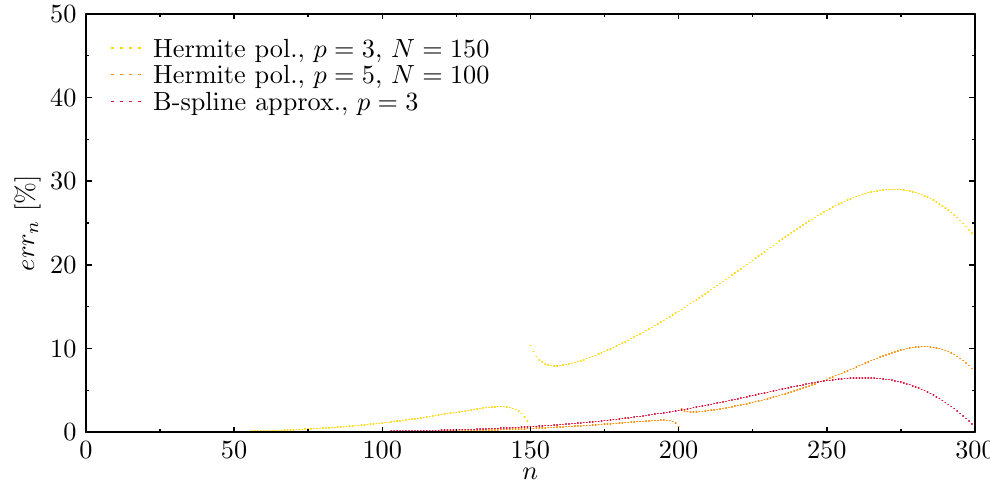
Figure 11. Relative errors of natural frequencies of the beam calculated based on different approximation polynomials, in the case of a beam with simply-supported ends.